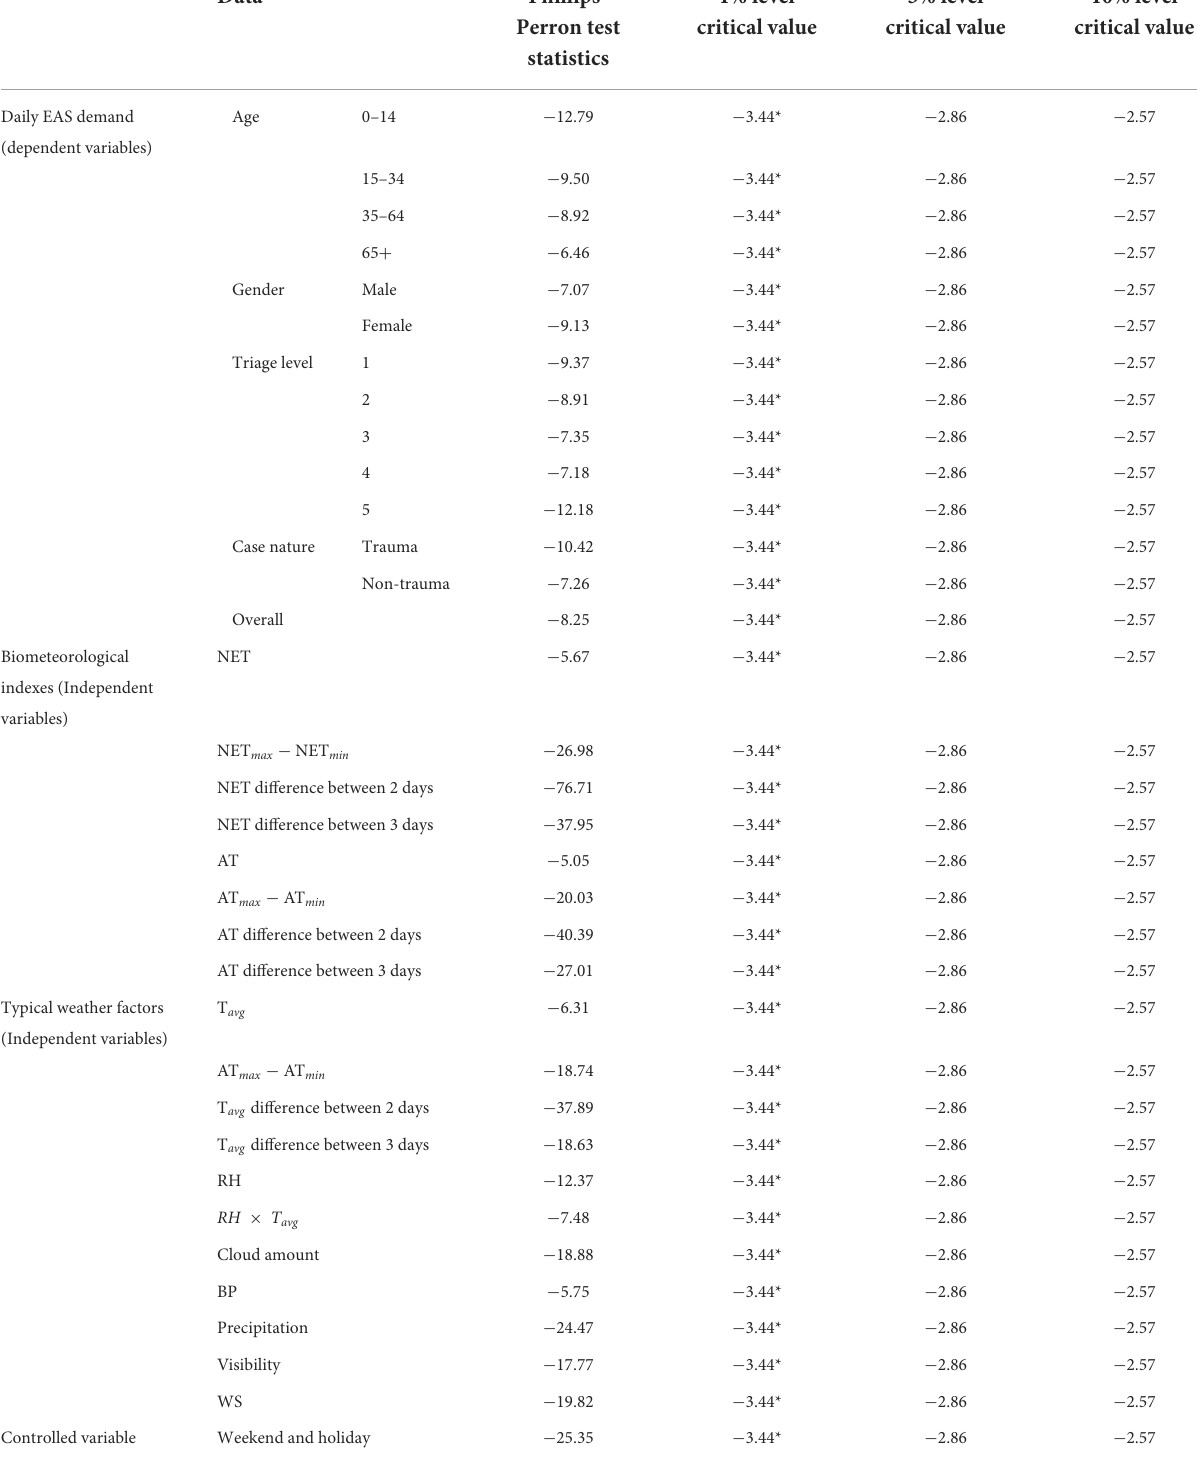
TABLE 1 Result of the Phillips-Perron unit root tests on the dependent and independent